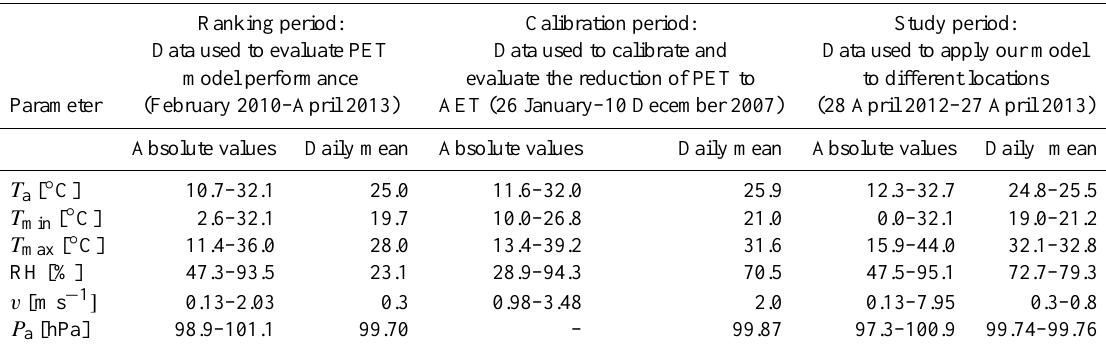
Table C1. Absolute values as well as daily means of meteorological input parameter (daily means of study period have ranges due to three meteorological stations). Ranking period: Calibration period: Study period: Data used to evaluate PET Data used to calibrate and Data used to apply our model model performance evaluate the reduction of PET to to different